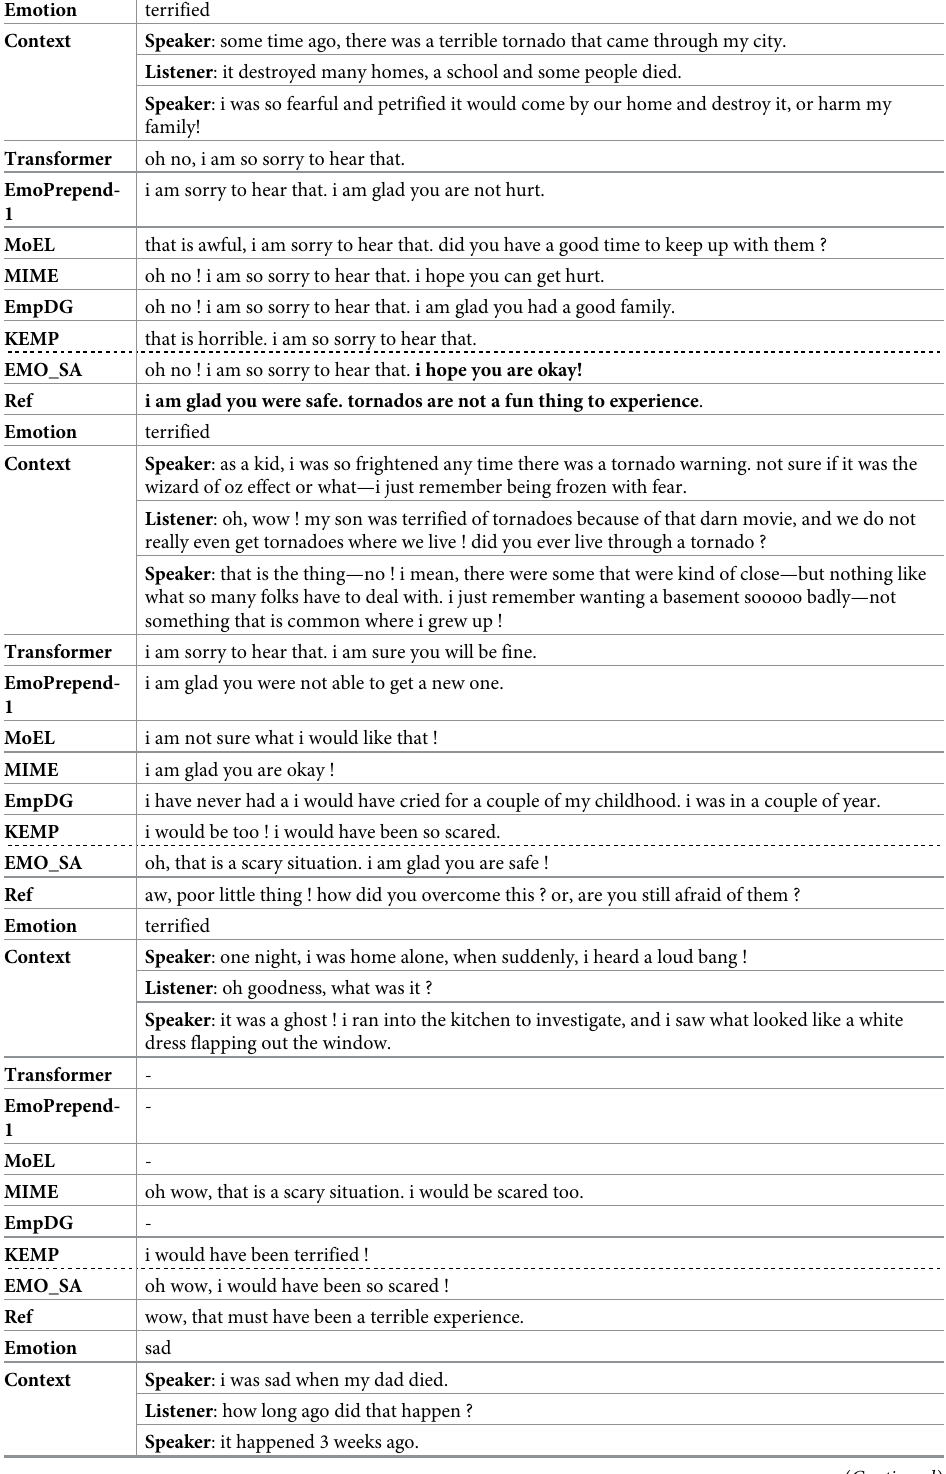
Table 5. Case study of the generated responses by EMO_SA and the